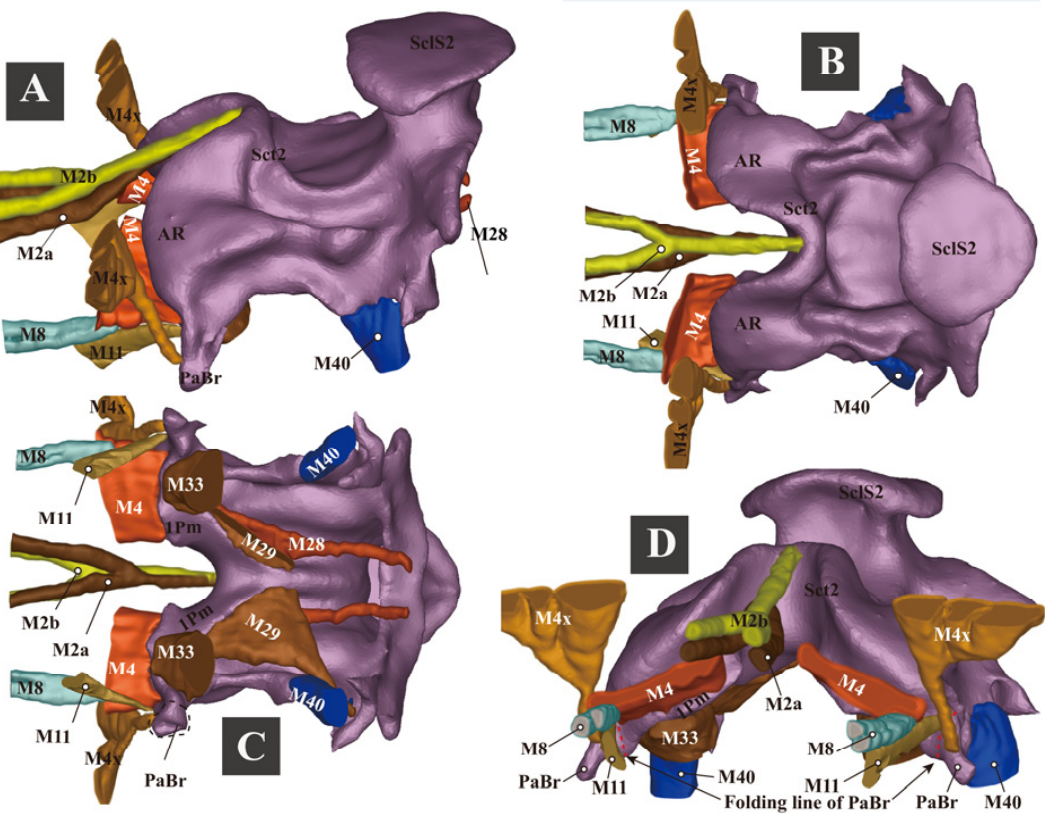
Figure 8. Three-dimensional reconstructions of the mesonotum and attached muscles of Campsoster- nus auratus . Muscles are partly cut to show details for other structures; see Section 2 ‘Materials and Methods’ for technical information and abbreviations. ( A ) lateral view. ( B ) dorsal view, anterior part facing left. ( C ) ventral view, anterior part facing left. ( D ) anterolateral